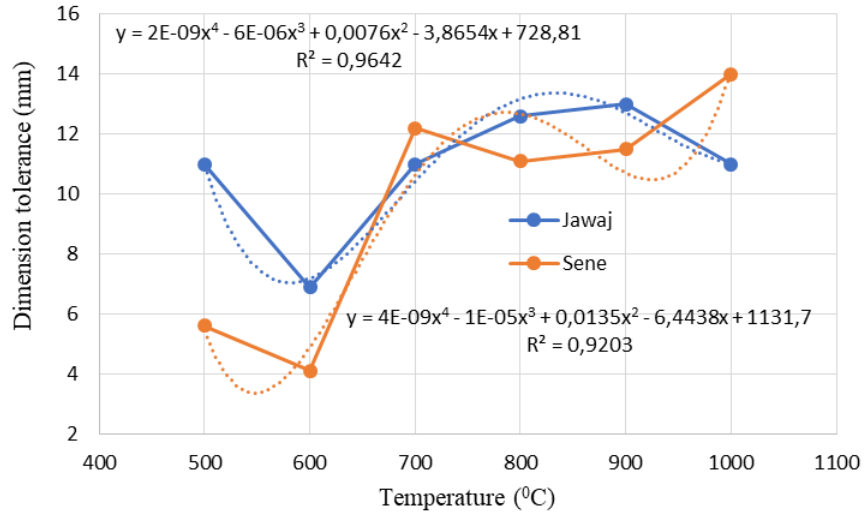
Figure 9: Average dimension tolerance test results along the width 120